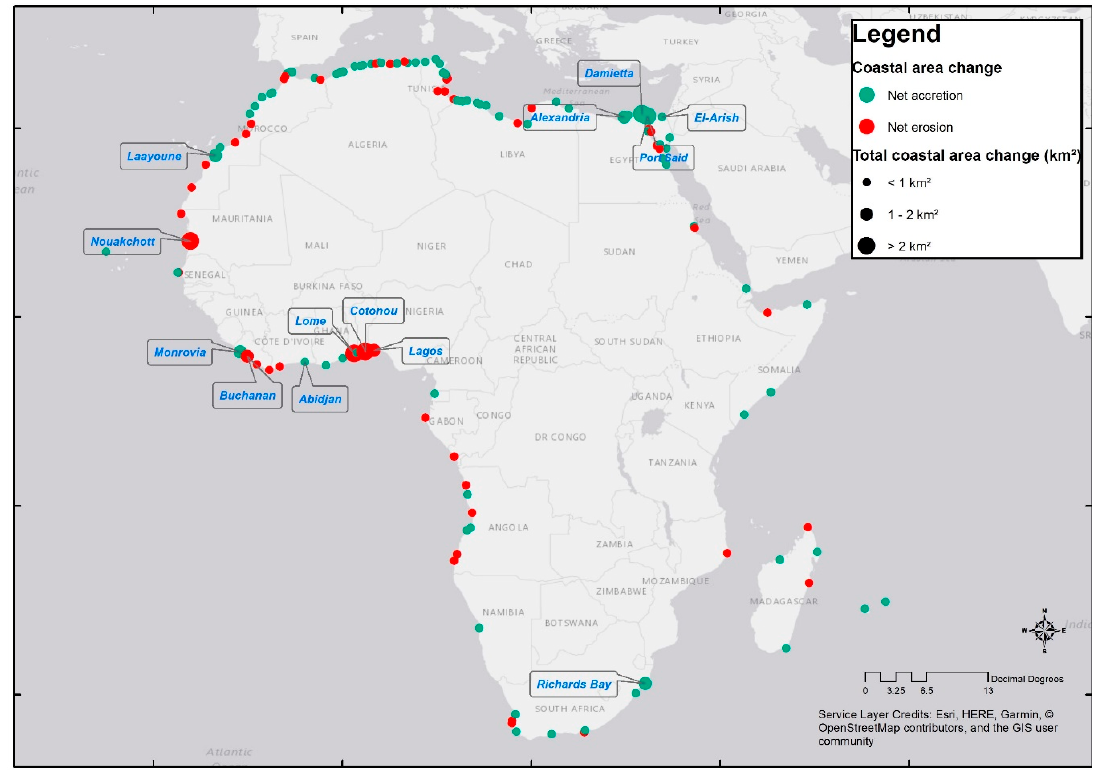
Figure 9. Geographical overview of the gross coastal areal changes adjacent to 130 African seaports. The size of the dots represents the gross beach area change and the colour represents whether this is dominated by accretion (green) or erosion (red). The top 10% hotspot ports in terms of gross historic changes are indicated by the text boxes. Table 2. Top 10 ports in terms of gross historic (left) and present (right) areal change (rate). Top 10 Historic